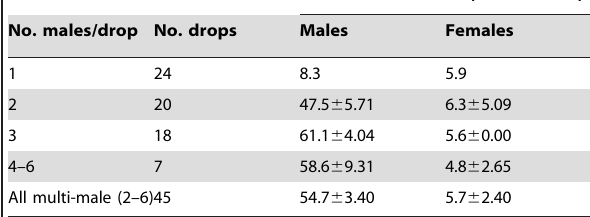
Table 2. Mortality (mean 6 SE) of S. longicaudum males and females developing together for 4–5 days in hanging drops of insect haemolymph inoculated with infective